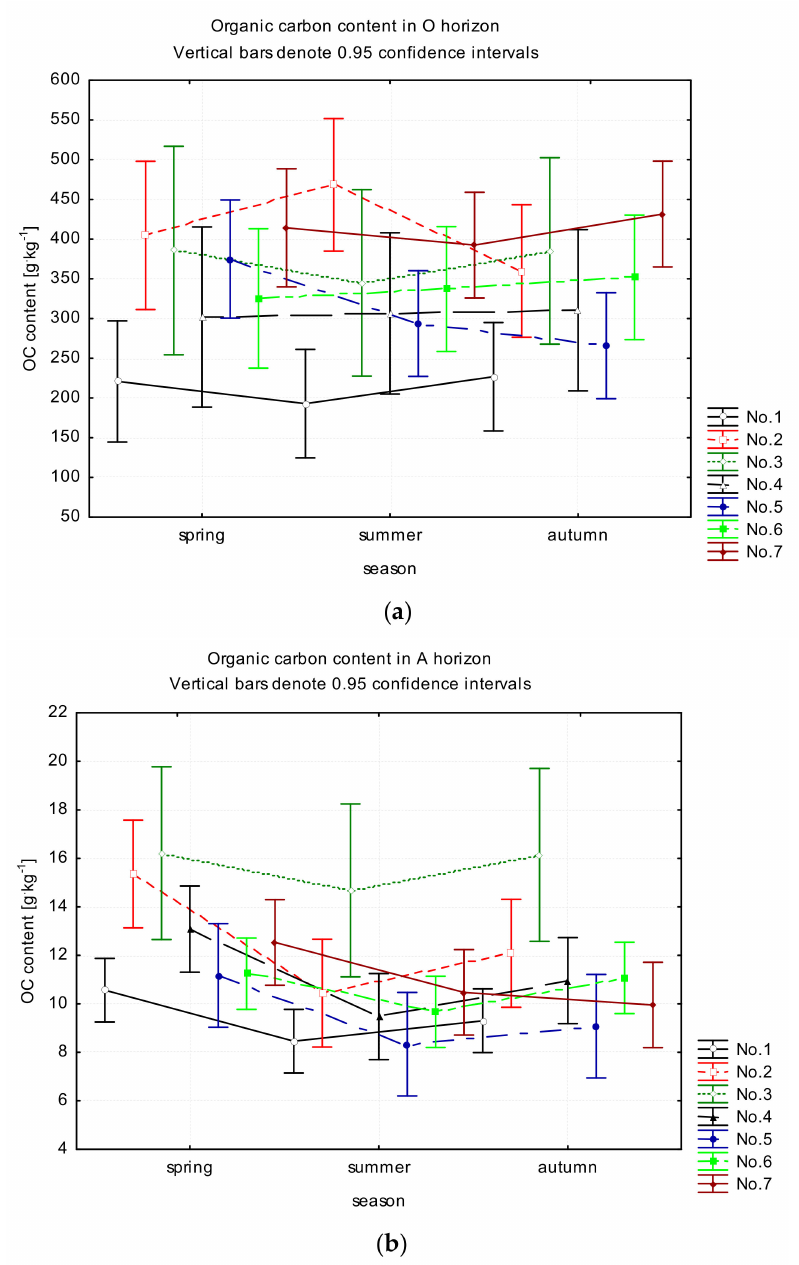
Figure 4. The average seasonal content of OC in the ( a ) O horizon and ( b ) A